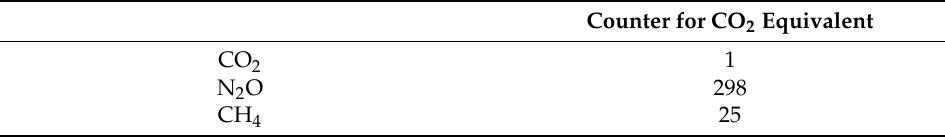
Table 2. Global warming potential 1 .